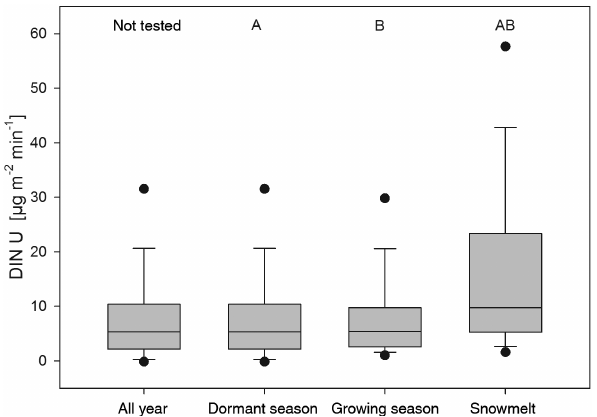
Figure 6. Boxplot of the seasonal differences in net NO − rates ( U ) per unit stream area during 2008–2011 in the BA-2 catch- ment. Solid lines represent median values, boxes the 25th to 75th percentile range, whiskers the 90th to 10th percentiles and dots the 95th and the 5th percentiles. Pairs of letters indicate highly signifi- cant differences between seasons ( p < 0.001; Mann–Whitney rank sum test). Values for BA-1 site are generally lower, but show similar seasonal